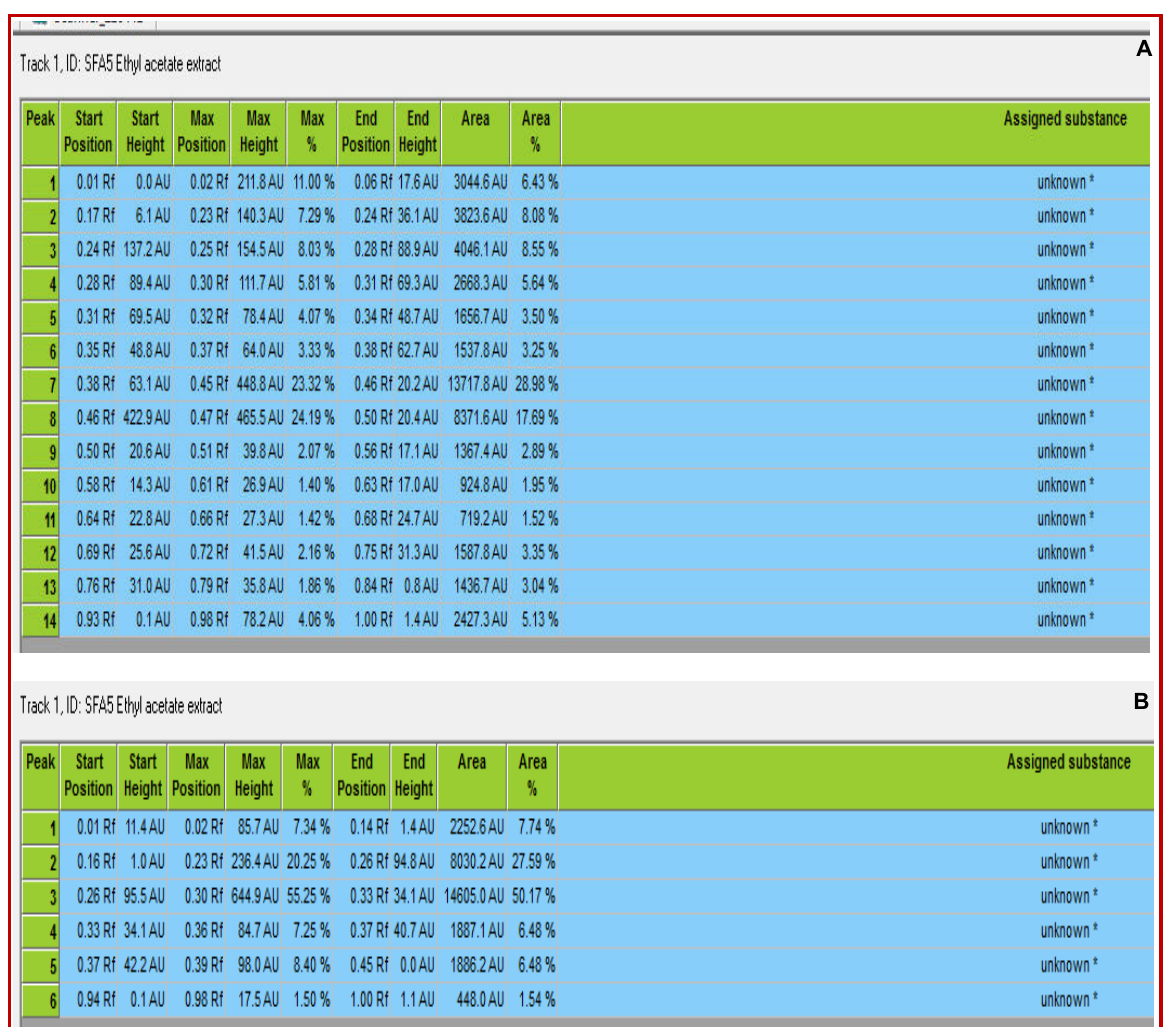
Figure 3: Rf values of ethyl acetate extract of SFA5 at UV 254 nm (A) and 366 nm